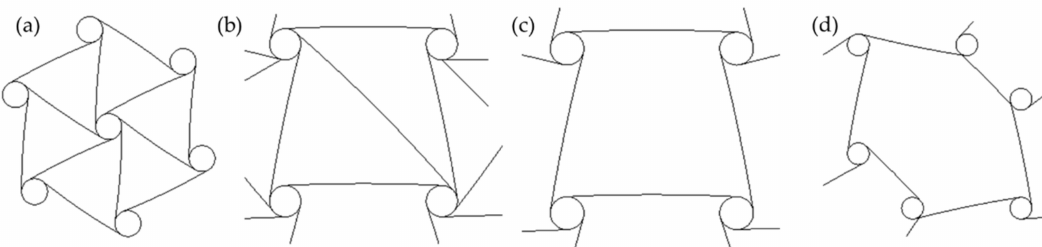
Figure 15. ( a ) 2D hexachiral and 2D meta-chiral systems with di ff erent number of ribs attached to each node ( b ) six ribs, ( c ) four ribs, and ( d ) three ribs [21].